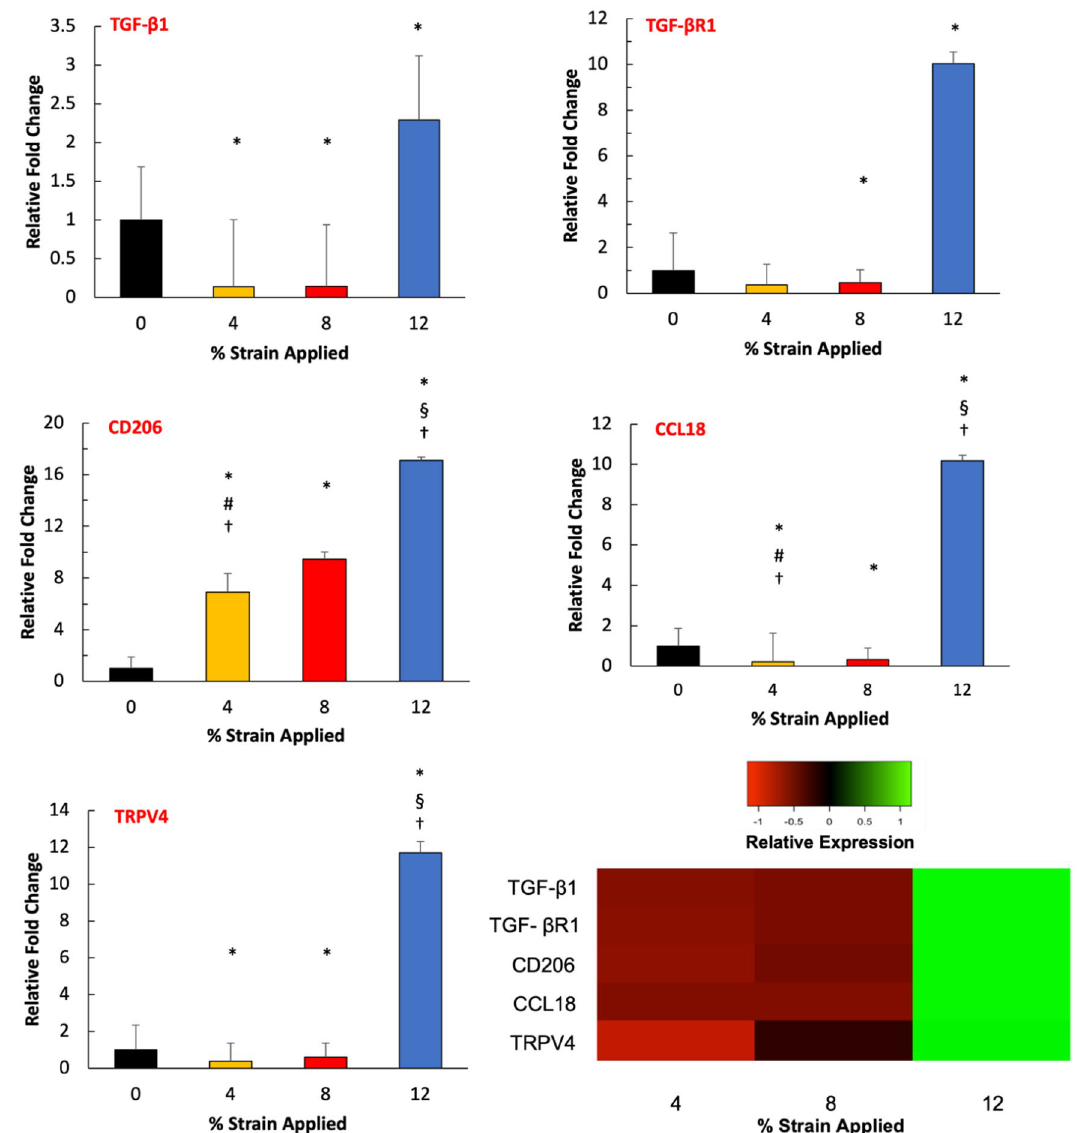
Figure 8. Effect of mechanical strain on the gene expression of activation stressors markers and profibrotic markers within 3D tissue analogues. The heatmap represents a color-coding of average z-scores obtained from mRNA fold changes. Green indicates an expression greater than the mean; red indicates an expression lower than the mean, and black indicates a quantity close to the mean (n = 3). *Indicate significant difference with respect to 0% mechanical strain group (control) with P < 0.05. # Represent significant difference between 4 and 8% mechanical strain groups, § represent a significant difference between 8 and 12% mechanical strain groups, and † represent a significant difference between 4 and 12% strain groups, each with a 0.05